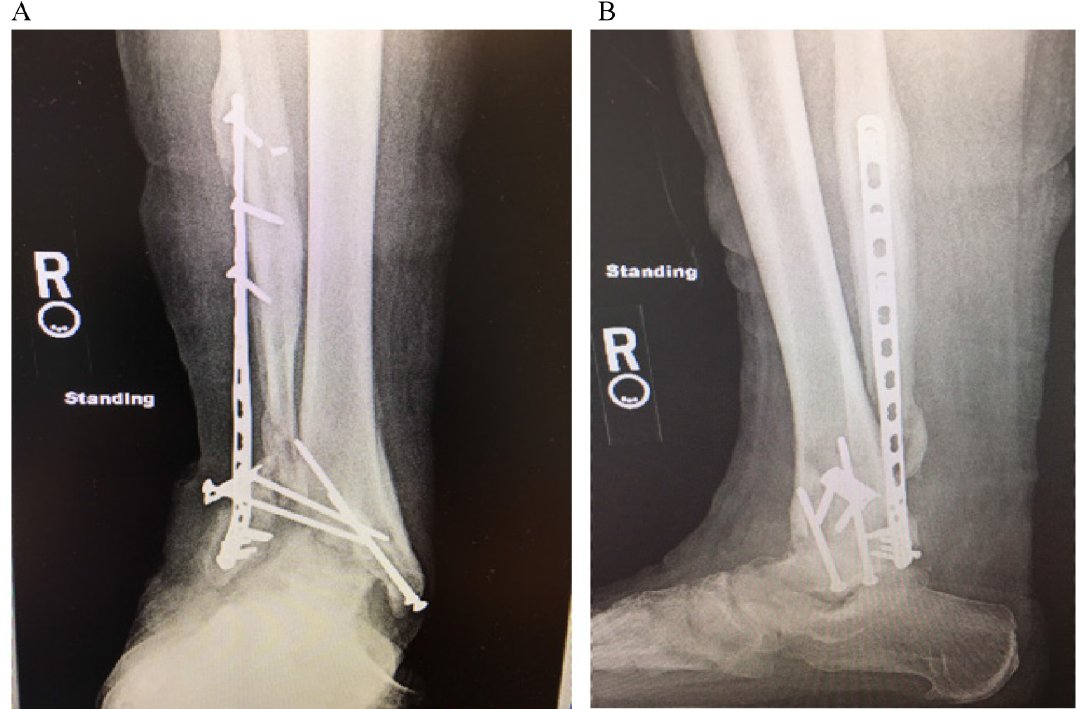
Figure 1: AP (A) and lateral (B) radiograph demonstrating hardware failure and destruction of the tibiotalar joint with severe valgus deformity and non-union